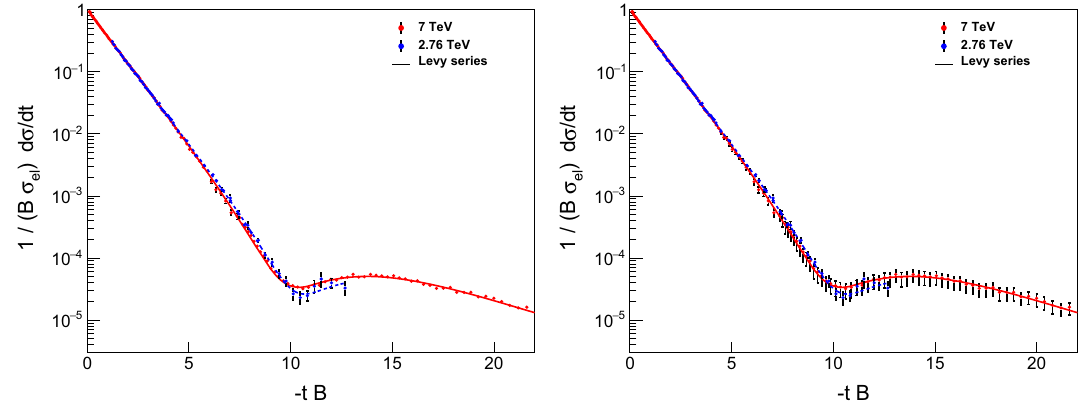
Fig. 5 Same as Fig. 4, but now the H ( x ) scaling of the differential cross section d σ/ dt of elastic pp collisions is compared at the nearby √ s = 2 . 76 and 7 TeV LHC energies. Left panel shows the data with